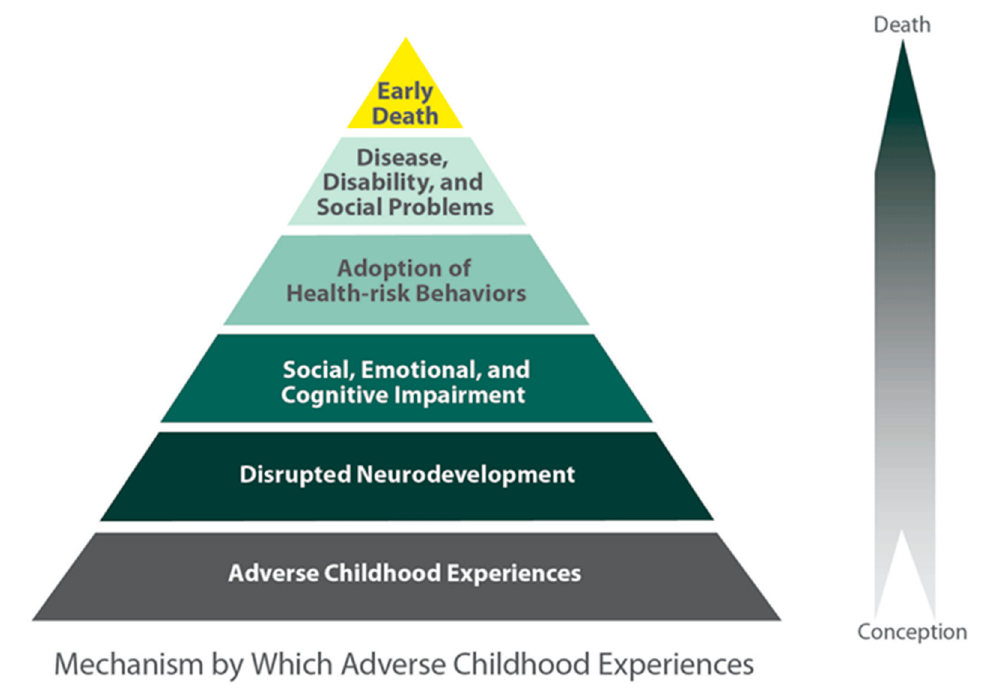
Figure 1. Adverse childhood experiences (ACE) pyramid.